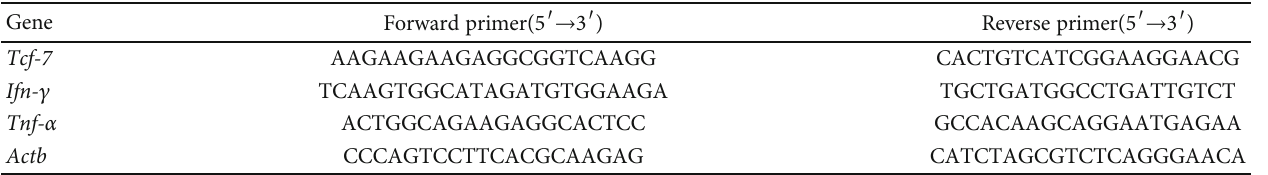
Table 2: Primers used for qPCR.